Question: What type of chart is this?
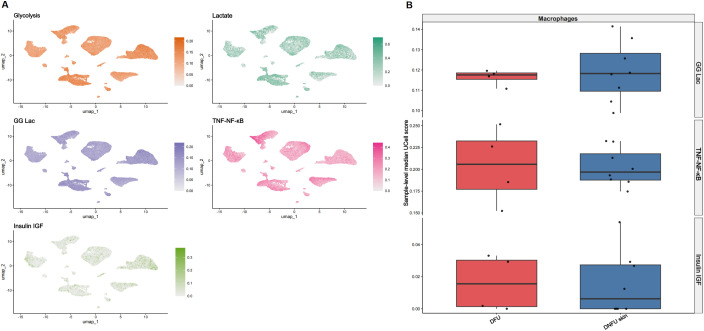
Answer: scatter